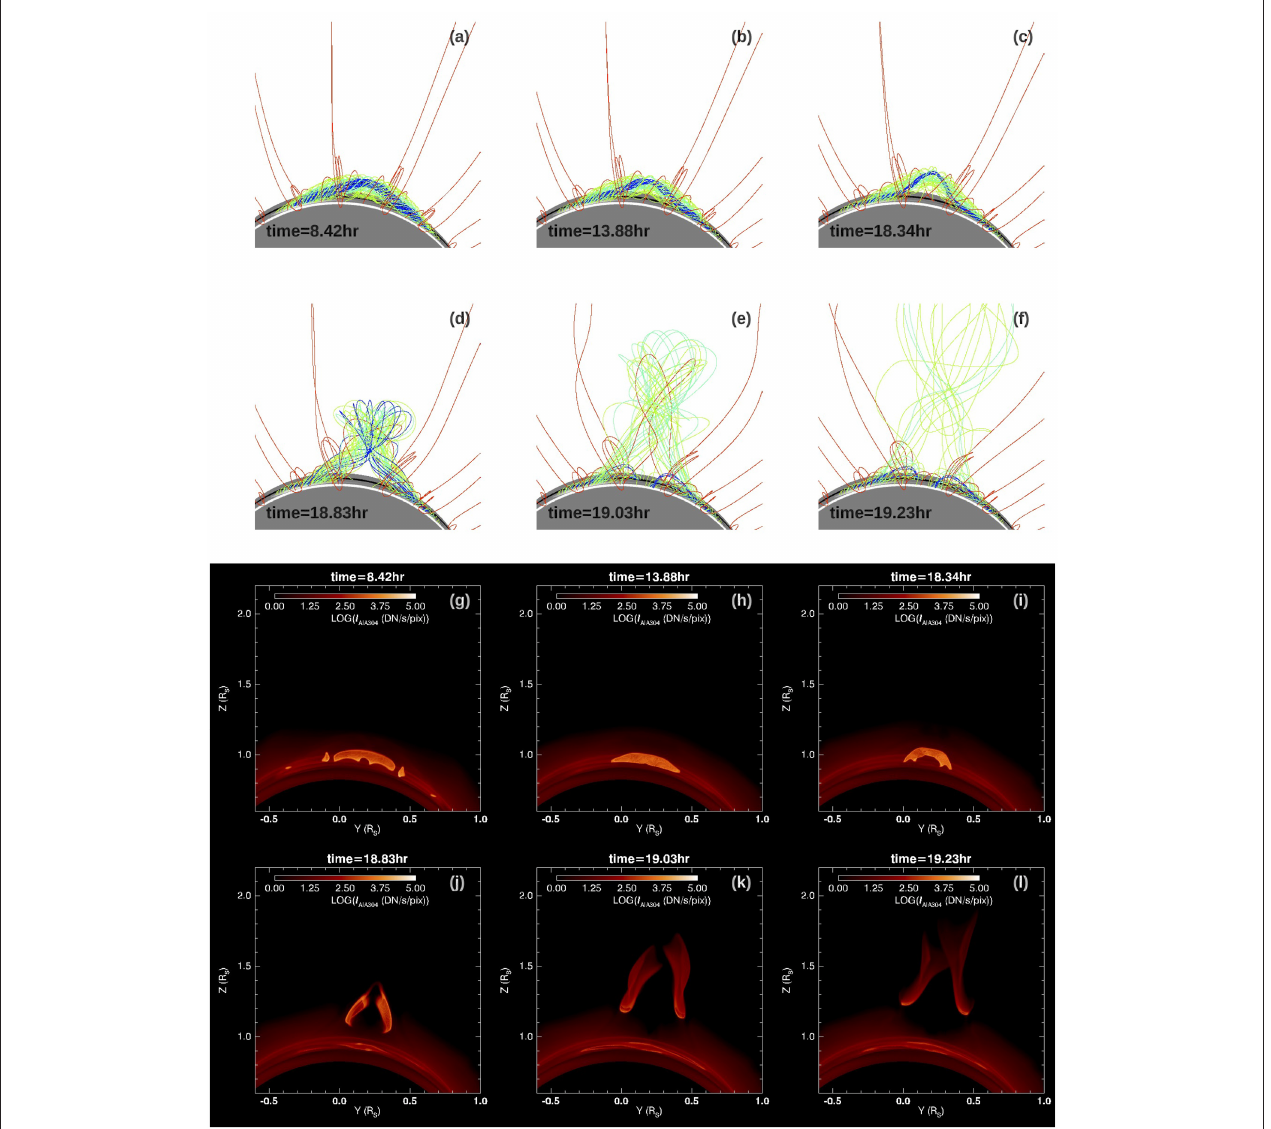
FIGURE 2 | (a–f) show a sequence of snapshots of the 3D magnetic field lines through the course of the evolution of the emerged coronal flux rope, and (g–l) show the corresponding synthetic SDO/AIA EUV images in 304 Å channel from the same perspective view.